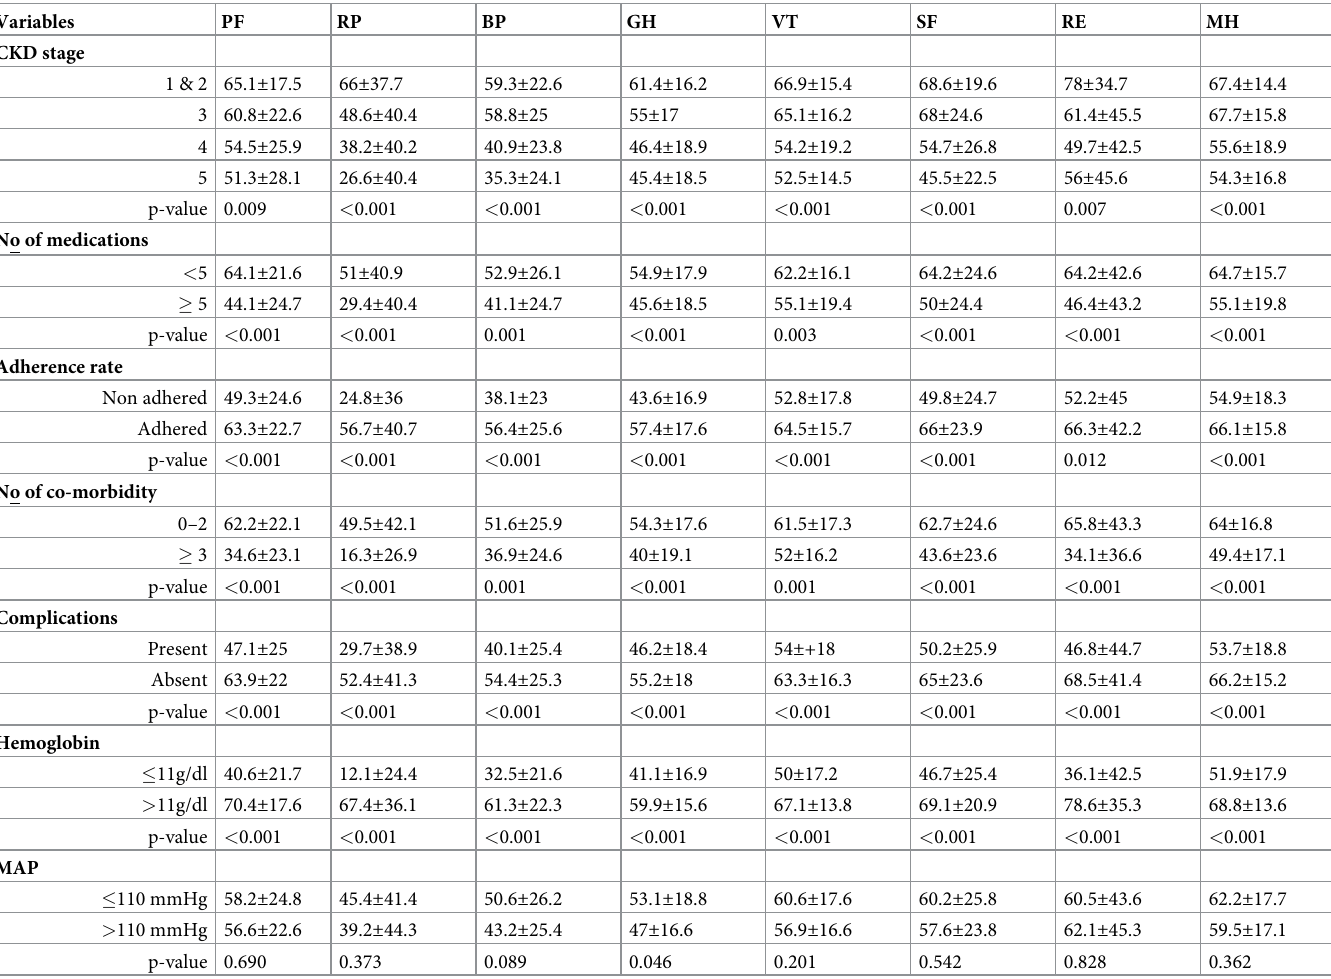
Table 5. Comparative statistical analysis of the mean scores of SF-36 domains of patients with chronic kidney disease, according to the categorical clinical/labora- tory